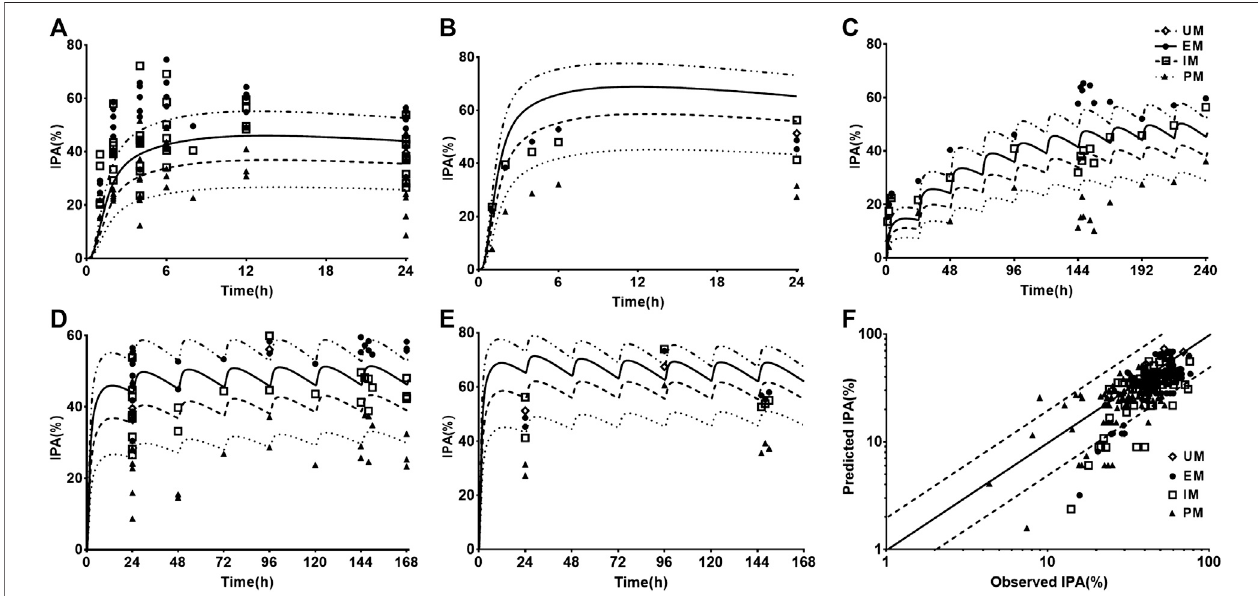
FIGURE3| Thepredicted(line)andobserved(point)IPA-timepro fi lesinhealthyvolunteers. (A) IPA(%)after300 mgsingledose.Theobservationswerecitedfrom Kim(2008,EM n (cid:1) 8,IM n (cid:1) 8,PM n (cid:1) 8)(Kimetal.,2008),Kim(2016,EM n (cid:1) 9,IM n (cid:1) 9,PM n (cid:1) 9)(Kimetal.,2016),Kobayashi(EM n (cid:1) 9,IM n (cid:1) 9,PM n (cid:1) 9)(Kobayashi et al., 2015), Simon (UM n (cid:1) 10, EM n (cid:1) 10, IM n (cid:1) 10, PM n (cid:1) 10) (Simon et al., 2011), Song (EM n (cid:1) 8, IM n (cid:1) 10, PM n (cid:1) 2) (Song et al., 2018), Tazaki (EM n (cid:1) 13, IM n (cid:1) 10, PM n (cid:1) 4) (Tazaki et al., 2012), Umemura (EM n (cid:1) 8, IM n (cid:1) 21, PM n (cid:1) 7) (Umemura and Iwaki, 2016) and Zhang (EM n (cid:1) 16, IM n (cid:1) 16, PM n (cid:1) 16) (Zhang et al., 2020). (B) IPA (%) after 600 mg single dose, whose observed data were from Kobayashi (EM n (cid:1) 9, IM n (cid:1) 9, PM n (cid:1) 9) (Kobayashi et al., 2015) and Simon (UM n (cid:1) 10, EM n (cid:1) 10, IM n (cid:1) 10, PM n (cid:1) 10) (Simon et al., 2011). (C) IPA(%) after multidose of 75 mg, whose observations were from Horenstein (EM n (cid:1) 6, IM n (cid:1) 6, PM n (cid:1) 6)(Horensteinetal.,2014),Kelly(EM n (cid:1) 34,IM n (cid:1) 38,PM n (cid:1) 11)(Kellyetal.,2012)andNakkam(EM n (cid:1) 13,IM n (cid:1) 18,PM n (cid:1) 4)(Nakkam etal.,2015). (D) IPA(%) after 300 mg loading dose followed by 75 mg maintenance dose, whose observationswere from Kim (2008, EM n (cid:1) 8, IM n (cid:1) 8,PM n (cid:1) 8) (Kim et al., 2008),Kim (2014, EM n (cid:1) 33,IM n (cid:1) 37,PM n (cid:1) 32)(Kimetal.,2014),Kim(2016,EM n (cid:1) 9,IM n (cid:1) 9,PM n (cid:1) 9)(Kimetal.,2016),Kobayashi(EM n (cid:1) 9,IM n (cid:1) 9,PM n (cid:1) 9)(Kobayashietal., 2015),Simon(UM n (cid:1) 10,EM n (cid:1) 10,IM n (cid:1) 10,PM n (cid:1) 10)(Simonetal.,2011),Song(EM n (cid:1) 8,IM n (cid:1) 10,PM n (cid:1) 2)(Songetal.,2018),Tazaki(EM n (cid:1) 13,IM n (cid:1) 10,PM n (cid:1) 4)(Tazakietal.,2012)andZhang(EM n (cid:1) 16,IM n (cid:1) 16,PM n (cid:1) 16)(Zhangetal.,2020). (E) IPA(%)after600 mgloadingdosefollowedby150 mgmaintenancedose, whoseobservationswerefromKobayashi(EM n (cid:1) 9,IM n (cid:1) 9,PM n (cid:1) 9)(Kobayashietal.,2015),Simon(UM n (cid:1) 10,EM n (cid:1) 10,IM n (cid:1) 10,PM n (cid:1) 10)(Simonetal.,2011). (F) The relationship between the observed and predicted IPA (%). Solid and dashed lines respectively represent unity and 2-fold errors between observed and predicted data.